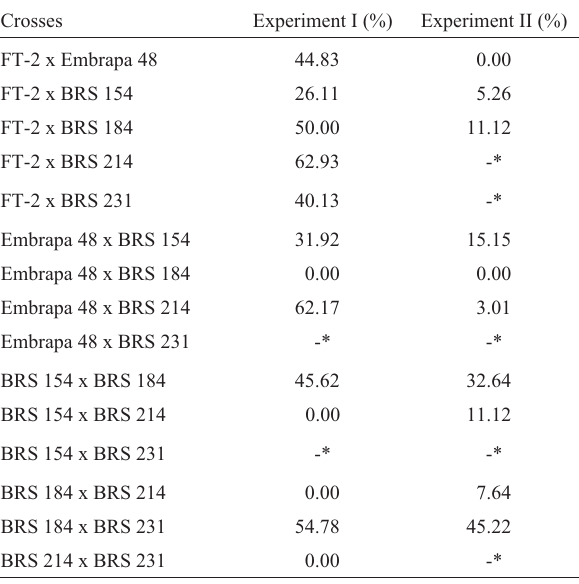
Table 4 - Narrow sense heritability estimates (h2 means from Experiments I and II.